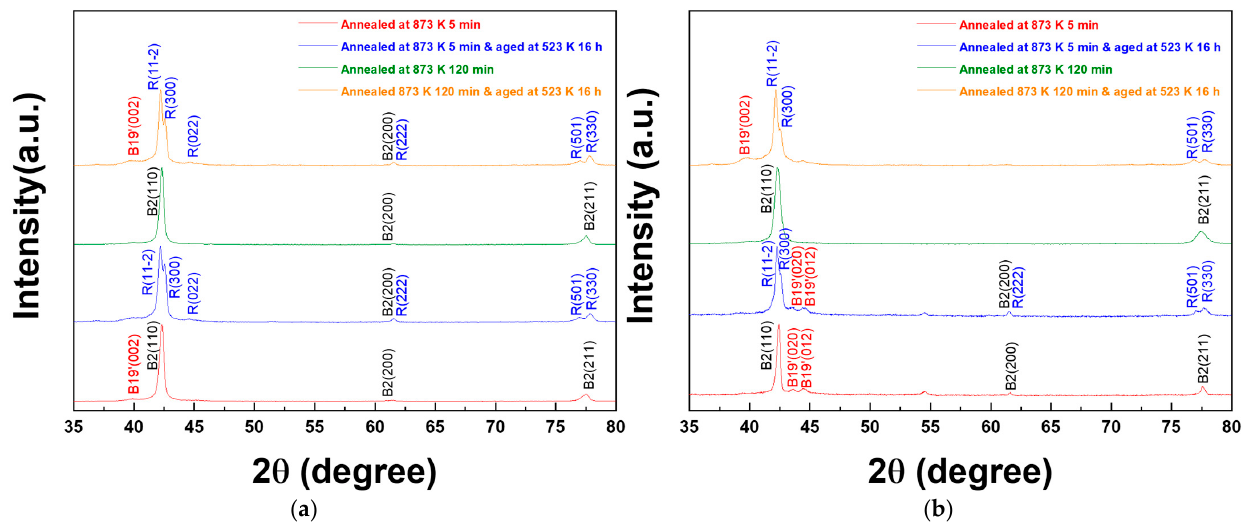
Figure 6. The XRD curves for the ( a ) AR and ( b ) HRDSR samples after annealing or annealing plus aging. Identification of phases was made based on the data from JCPDF cards (01 − 076 − 3614, 01 − 076 − 7519 and 01 − 076 − 4263). 01 − 076 − 7519 and 01 − 076 −